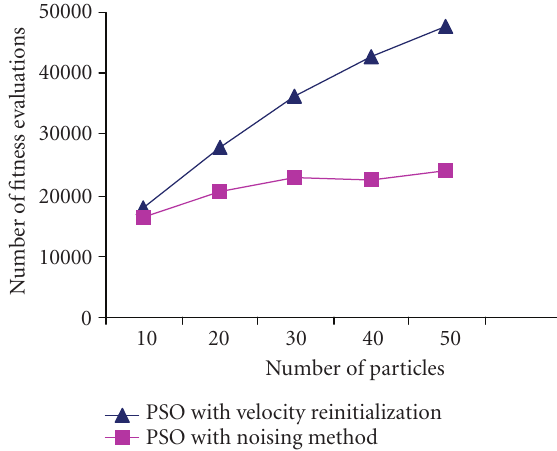
Figure 4.2 . Average number of fitness function evaluations to get the results of Figure